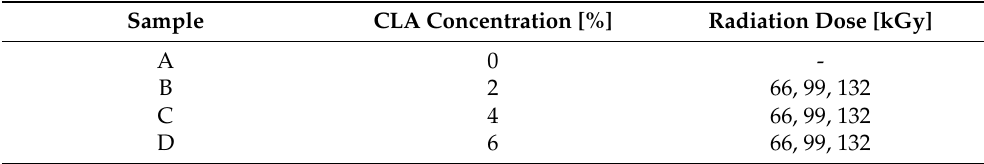
Table 1. Designation of test samples.